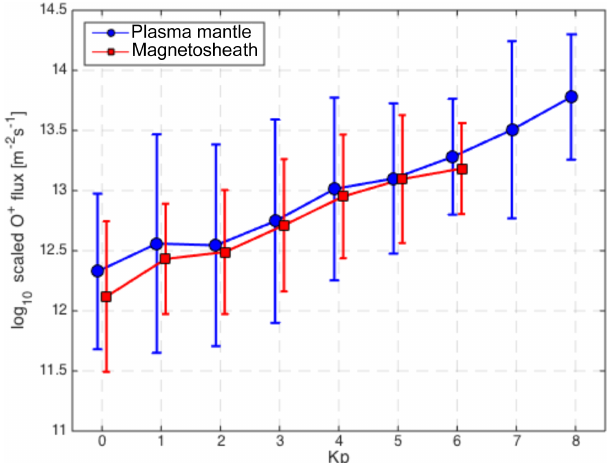
Figure 4. Distribution of O + observations over Kp for the plasma mantle (blue) and dayside magnetosheath (red) respectively. Figure 5. The average O + flux measured for the plasma mantle (blue circles) and in the magnetosheath (red squares), scaled to an ionospheric reference altitude as a function of Kp with error bars representing the standard